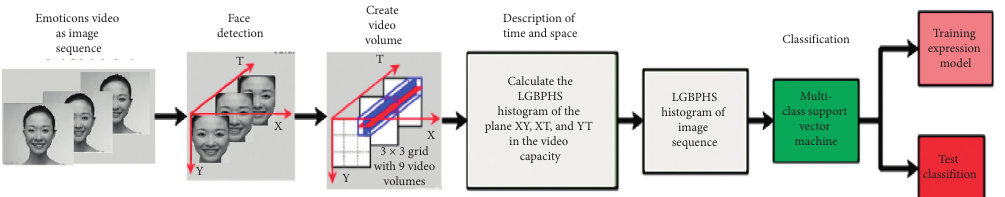
Figure 1: Expression recognition framework.